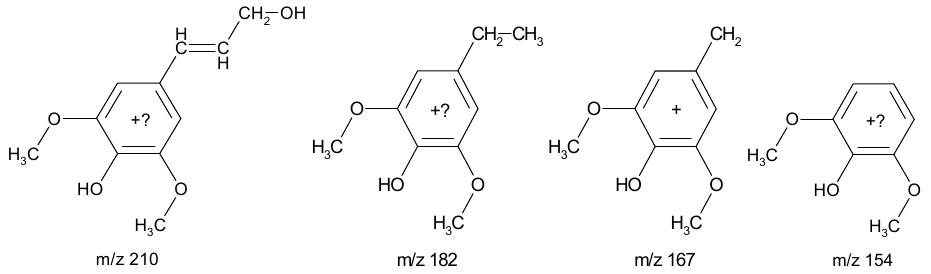
Figure 4. Mass spectrum of a compound identified as sinapyl alcohol.